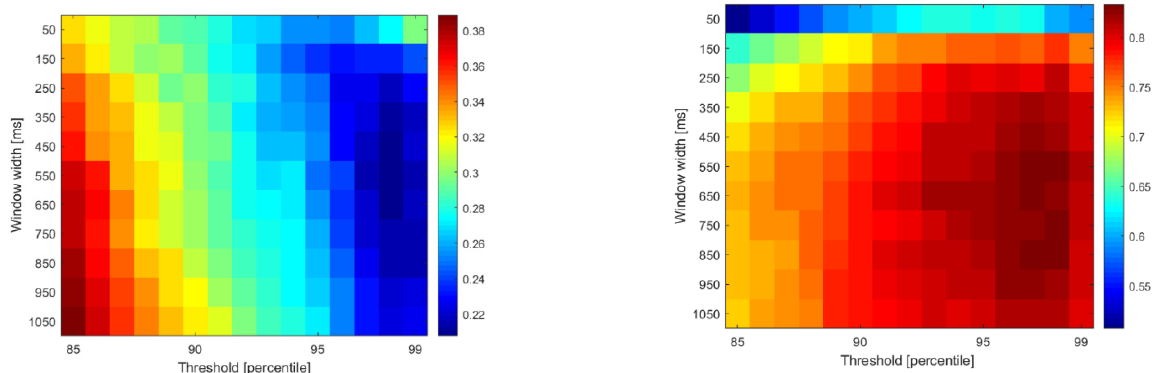
Figure 6. RMSE ( left ) and cross-correlation ( right ) of MAV algorithm for different window sizes. The cases of significant differences ( p < 0.05; Bonferroni-corrected) are marked with *.